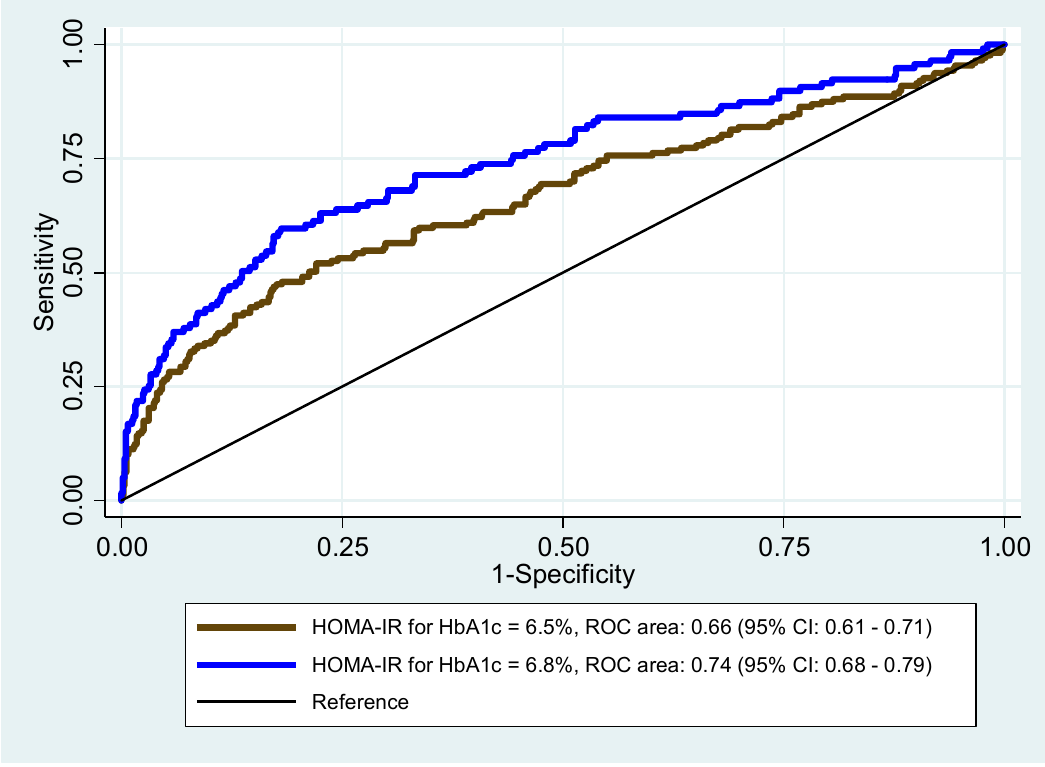
Figure 4. Receiver operating characteristics (ROC) curves for the homeostasis model assessment of insulin resistance (HOMA-IR) for cut-off values of HbA1c at 6.5% and 6.8%.